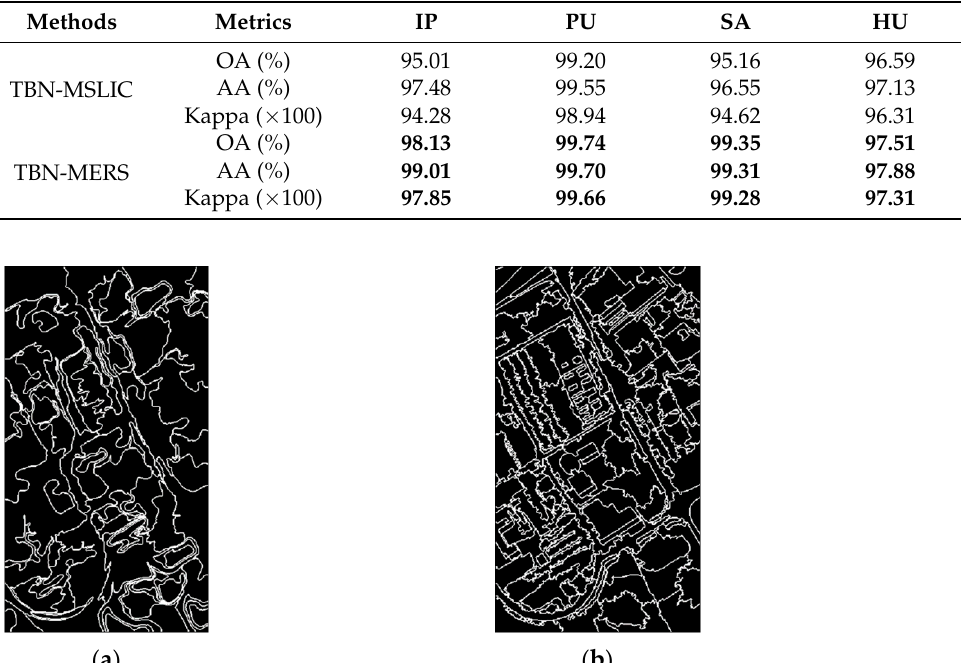
Figure 6. The segmentation image obtained by SLIC and ERS on the 103rd band of PU ( a ) SLIC ( b ) ERS.